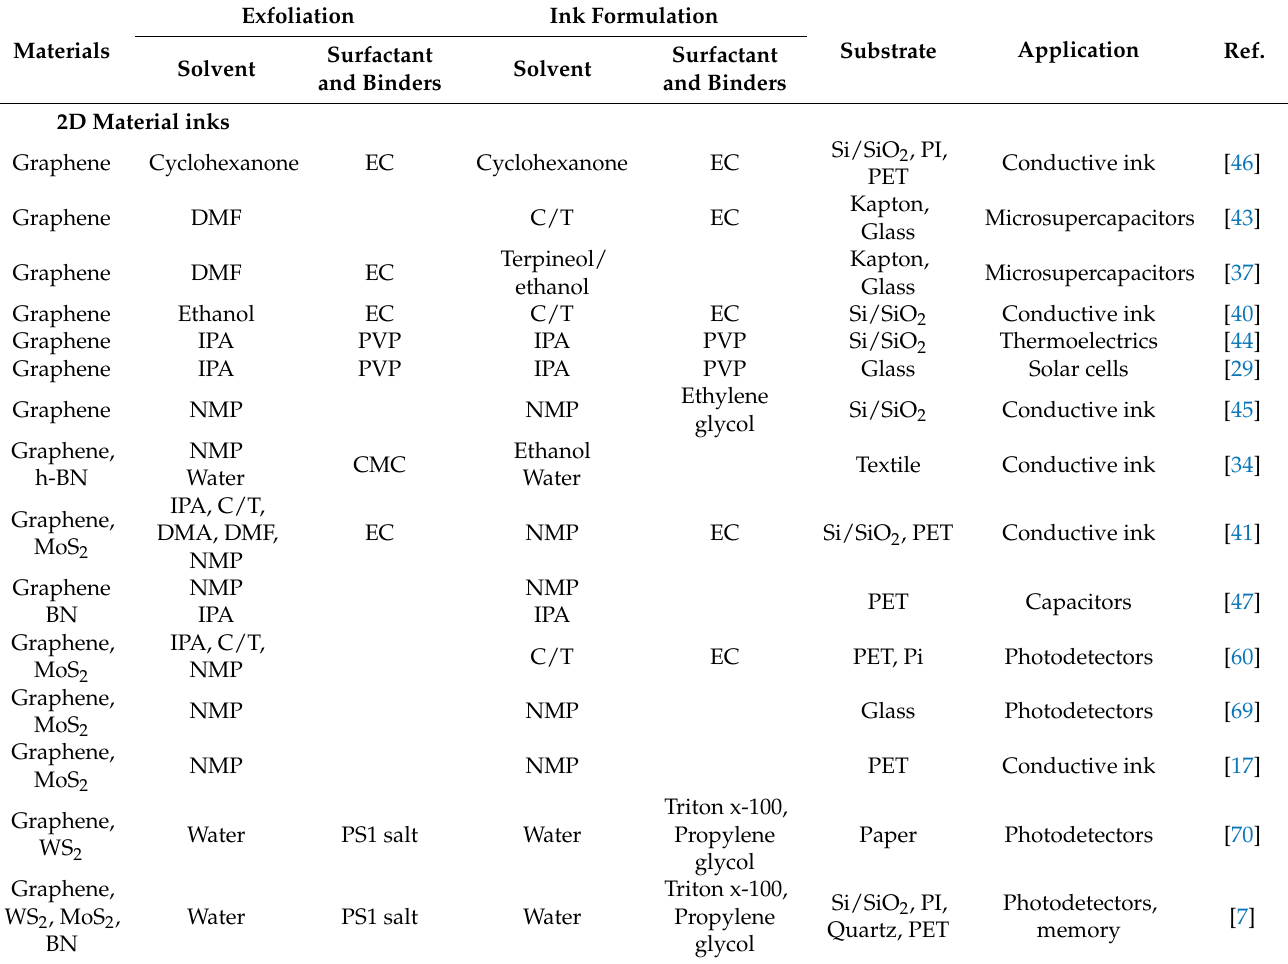
Table 2. Two-dimensional material inks and their printable